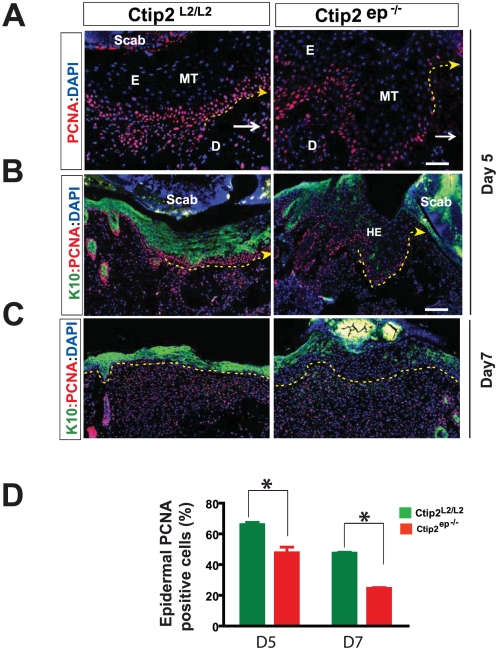
Reduced epidermal proliferation and differentiation in skin wounds from Ctip2ep−/− mice.(A–C) Expression of PCNA in skin sections from Ctip2L2/L2 and Ctip2ep−/− mice on day 5 (A and B) and day 7(C) post wounding, using antibodies against PCNA (in red). (B &C) Co-localization of K10 and PCNA on days 5 and 7 wound biopsies from dorsal skin of Ctip2L2/L2 and Ctip2ep−/− mice using anti-K10 antibody (green) and PCNA (red). All slides were counterstained with DAPI. The white arrow points to the directions of the wound (A). Yellow arrow with dotted lines indicates the direction of wound (B) and separates the epidermis from the dermis (C). MT-migratory tongue; HE- hyperproliferative epithelium; HF- hair follicle; E-epidermis and D- dermis. (D) Bar graph showing significant decrease (*P<0.05) in percentage of PCNA positive cells during wound healing on day 5 and 7 in the skin of Ctip2ep−/− mice. Green and red bars represent Ctip2L2/L2 and Ctip2ep−/− mice, respectively. Scale bars: 50 µm (A), 100 µm (B and C).